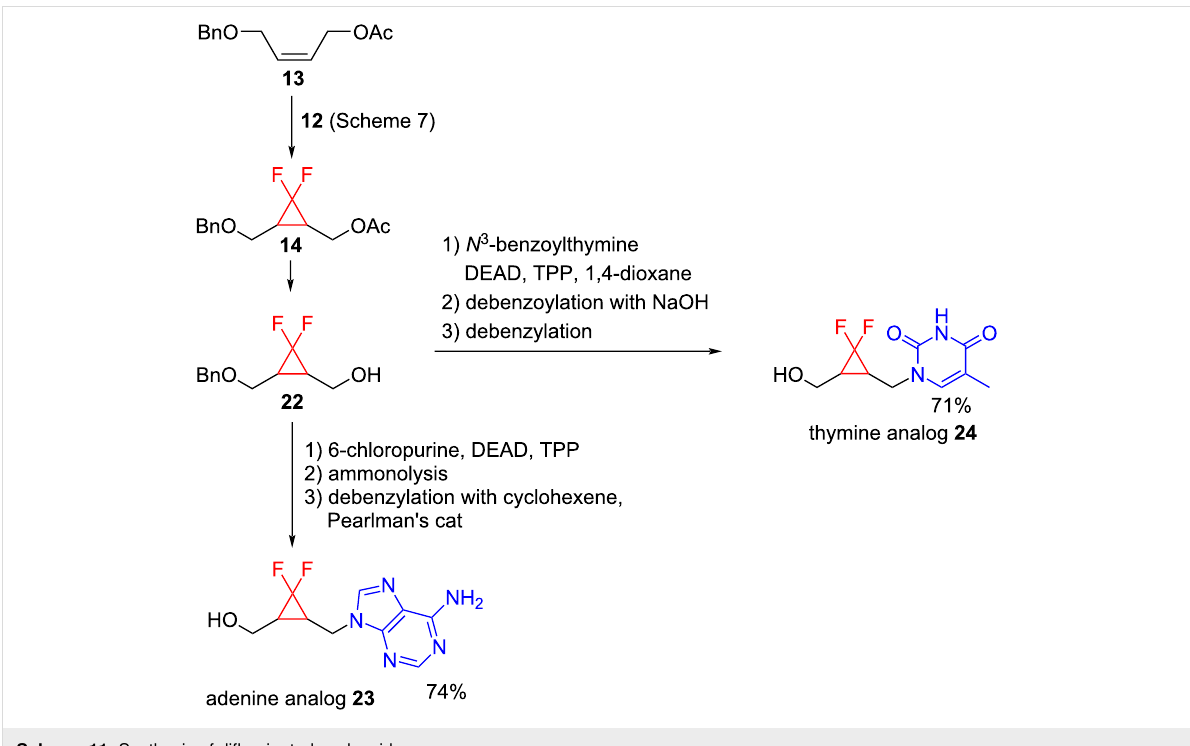
Scheme 11: Synthesis of difluorinated